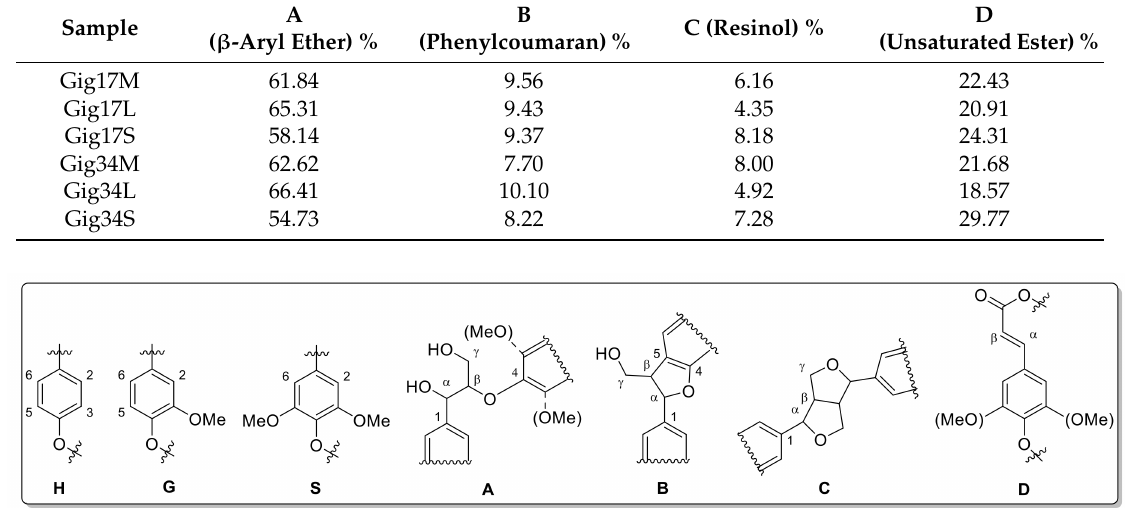
mixtures (Gig17M, Gig34M), stems (Gig17S, Gig34S), and leaves (Gig17L, Gig34L).